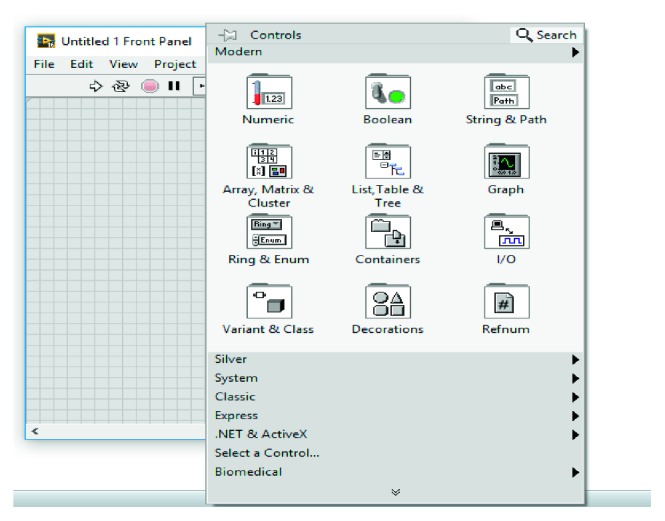
LabVIEW front panel.